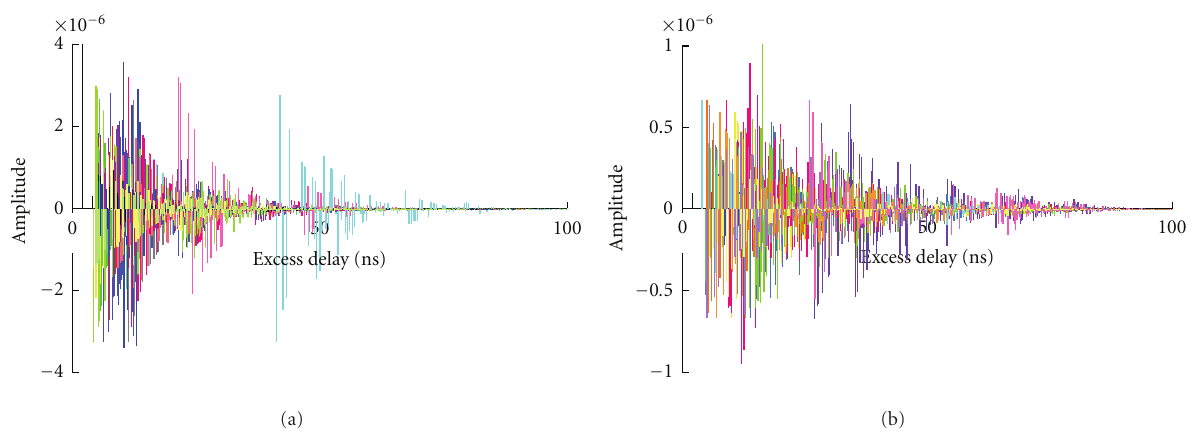
Figure 11: Examples of 20 channel response realizations for Room E ( V = 5 m 3 ): (a) LOS and (b)